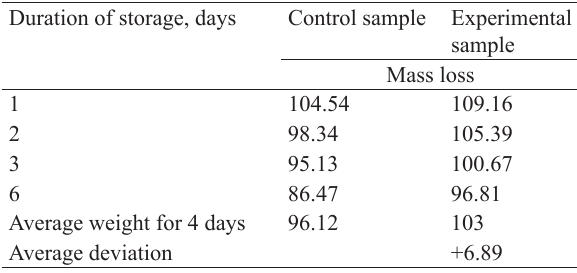
Table 9 Microbial contamination of pork